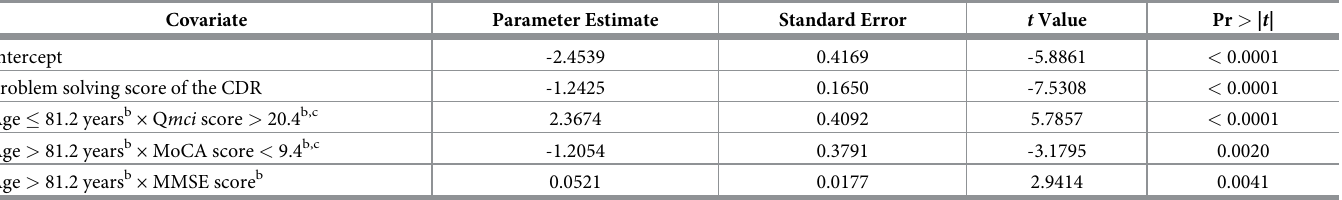
Table 2. Multivariate analysis of the predictors for the change score a of the Lawton IADL scale by fitting multiple linear regression model with the stepwise variable selection procedure.